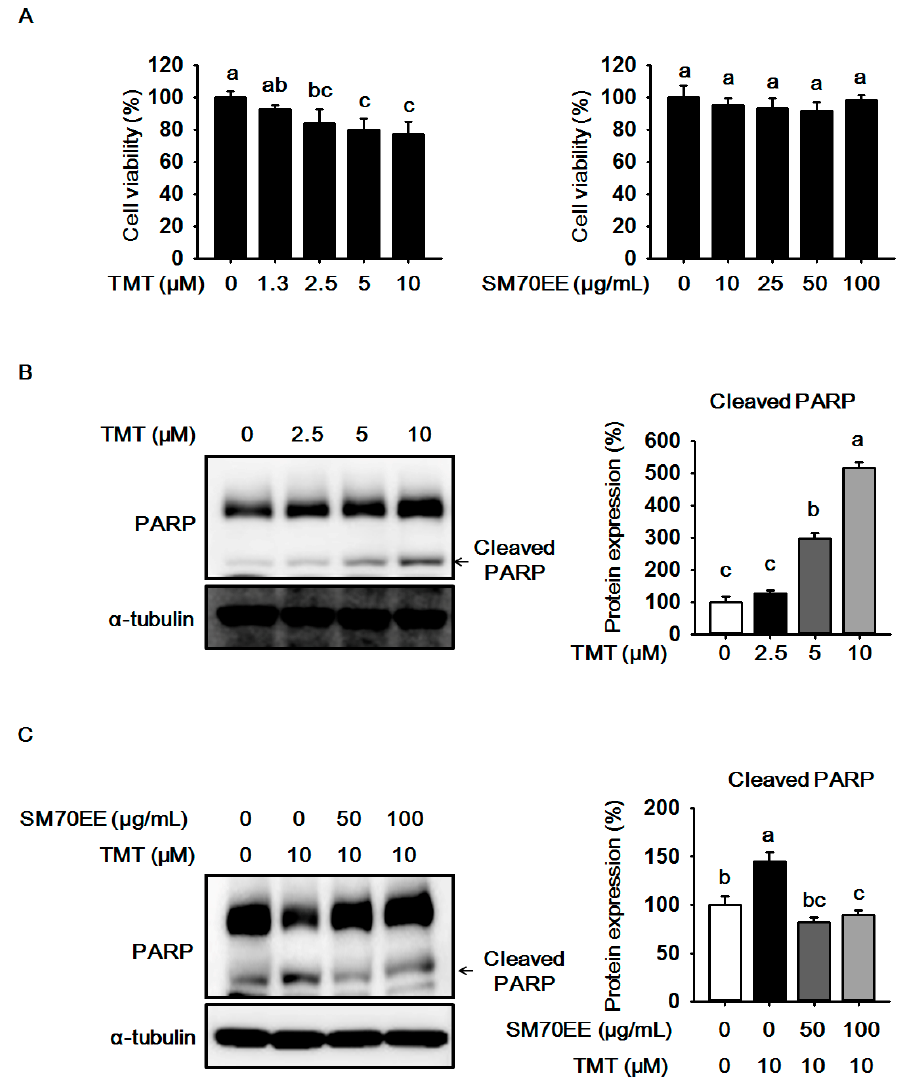
Figure 1. The effects of SM70EE on cell viability and neuronal death in HT-22 cells. ( A ) Cell viability was measured by a MTT assay. The experiments were performed in hexa-plicate; ( B ) HT-22 cells were treated with up to 10 µ M TMT. Cell lysates were subjected to western blot analysis to analyze to the expression of PARP; ( C ) HT-22 cells were pre-treated 50 and 100 µ g/mL SM70EE for 4 h before treatment with 10 µ M TMT for 24 h. Cell lysates were subjected to western blot analysis to probe the expression of PARP. The protein expression level was quantified using Image J software and normalized against α -tubulin and control. Results were analyzed by one-way analysis of variance (ANOVA) and Duncan’s multiple range tests. The p -value in the multiple comparison results (e.g., a, b, and c) indicate significant differences among the groups ( p < 0.05).